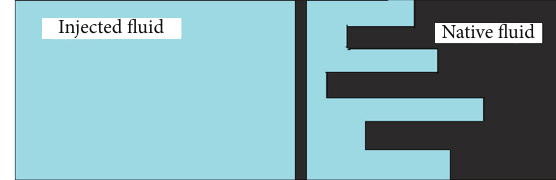
Figure 2: Schematic presentation of fingering (instability) phe-